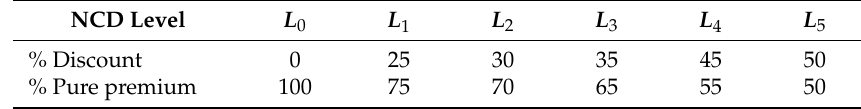
Table 1. Personal and corporate vehicle tari ff s under the current